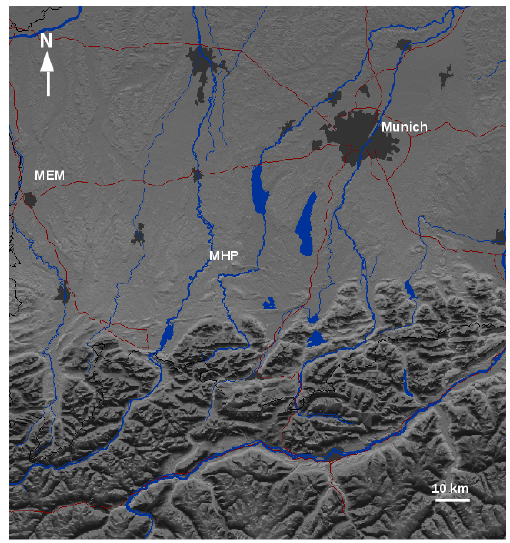
Figure 1. Geographic location of the observatory Hohenpeißenberg (MHP, 1000ma.s.l.) and the Memmingen radar (MEM). The sur- rounding orography is also